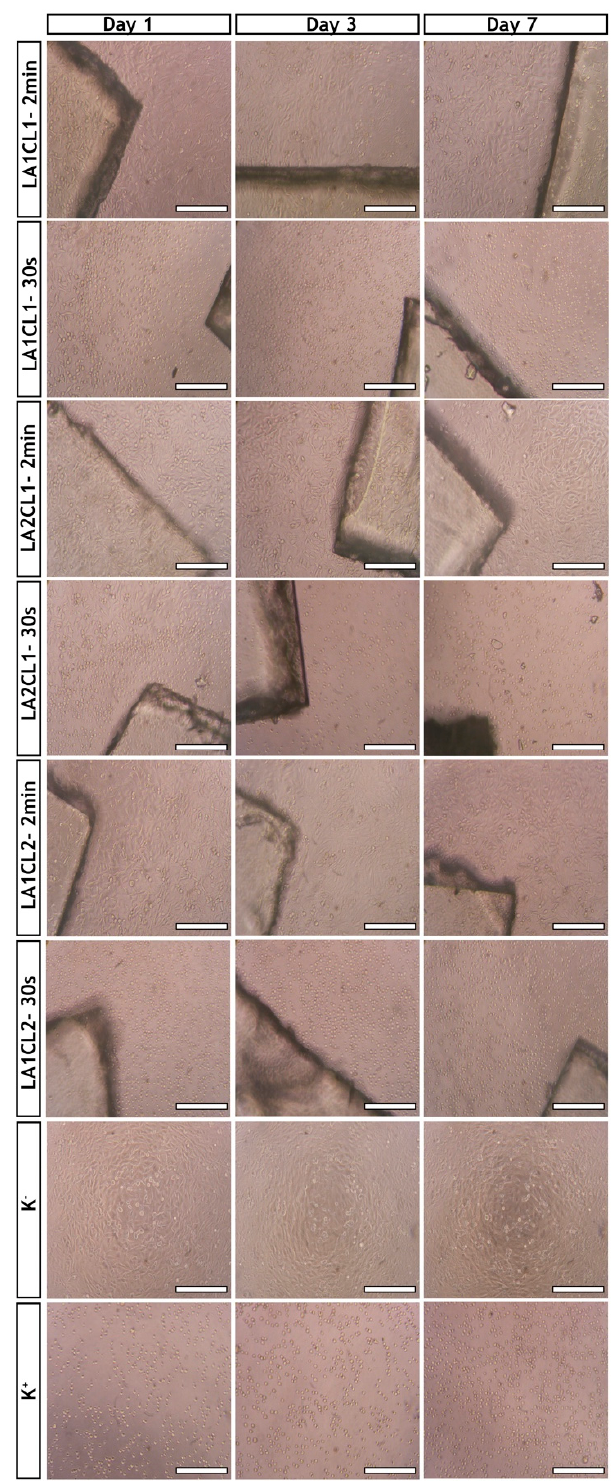
Figure 7. Optical microscopic images of NHDF cells cultured in the presence of produced films (LA1CL1, LA1CL2 and LA2CL1 photocrosslinked for 2 min and 30 s) for 1, 3 and 7 days; K − (negative control); K + (positive control). Scale bar represents 200 µm. Magnification 100×; resolution 1.2 µm.